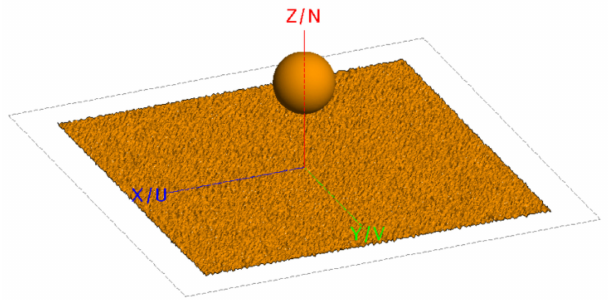
Figure 10. Rough surface and ball composite model.